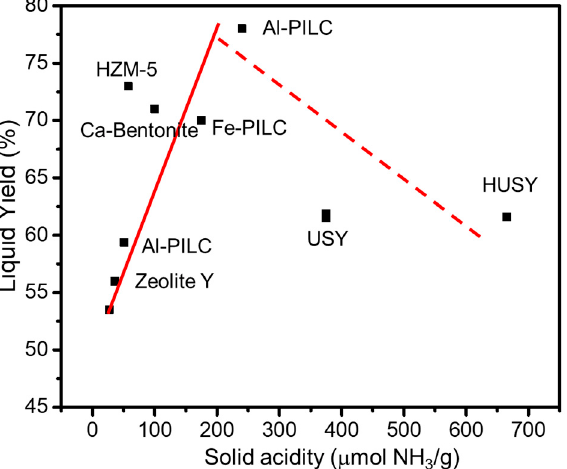
Figure 3. Relationship between solid acidity and liquid yield [27,33–37] .